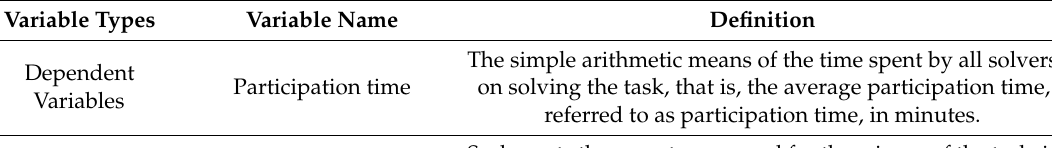
Table 1. Description of the definition of the main variables of the